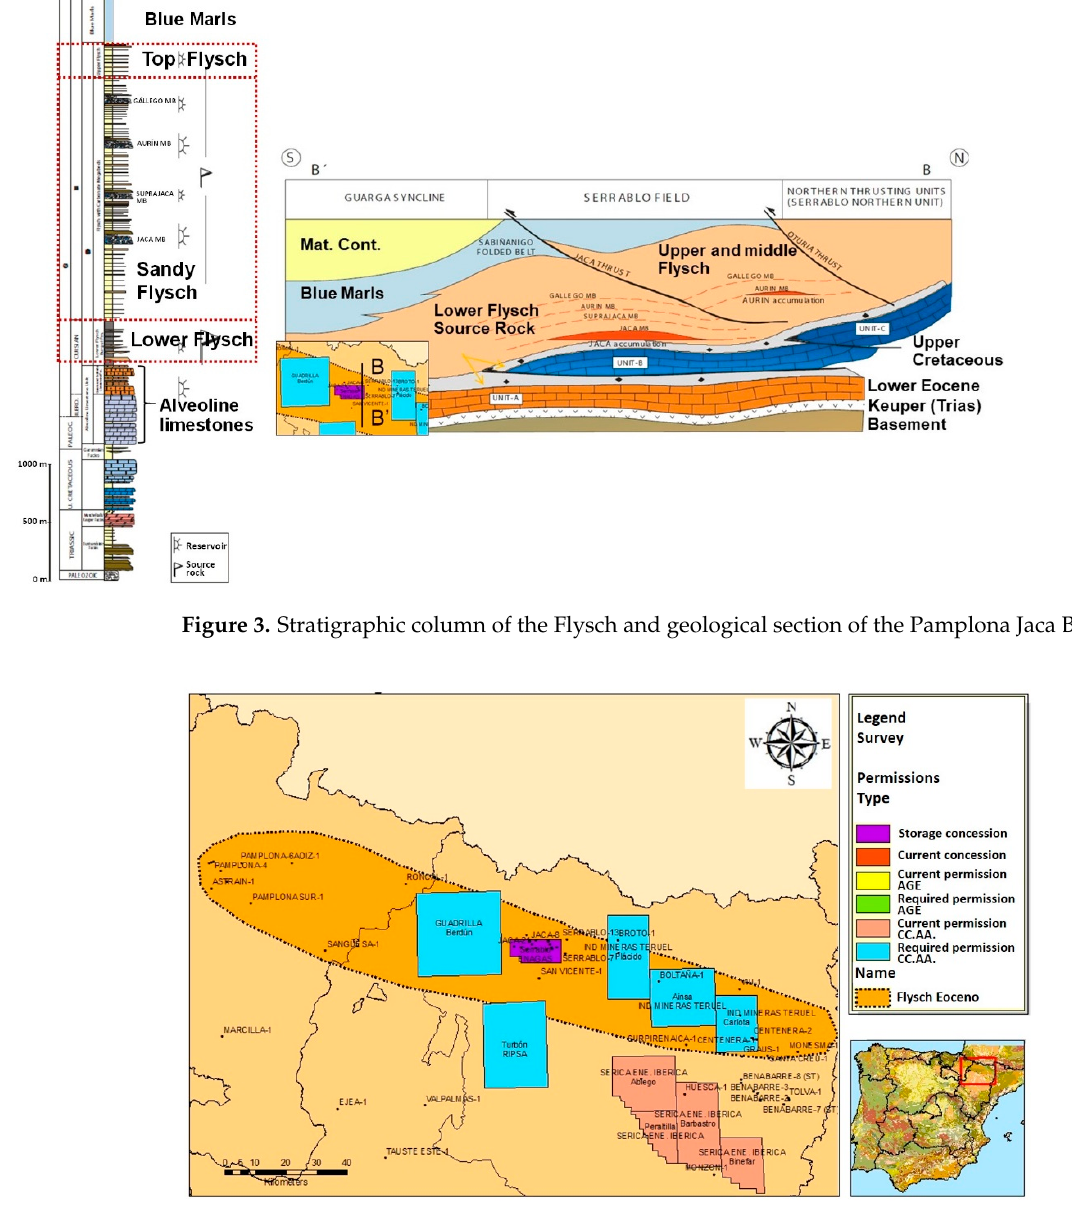
Figure 4. Location map of the Jaca Flysch [26].